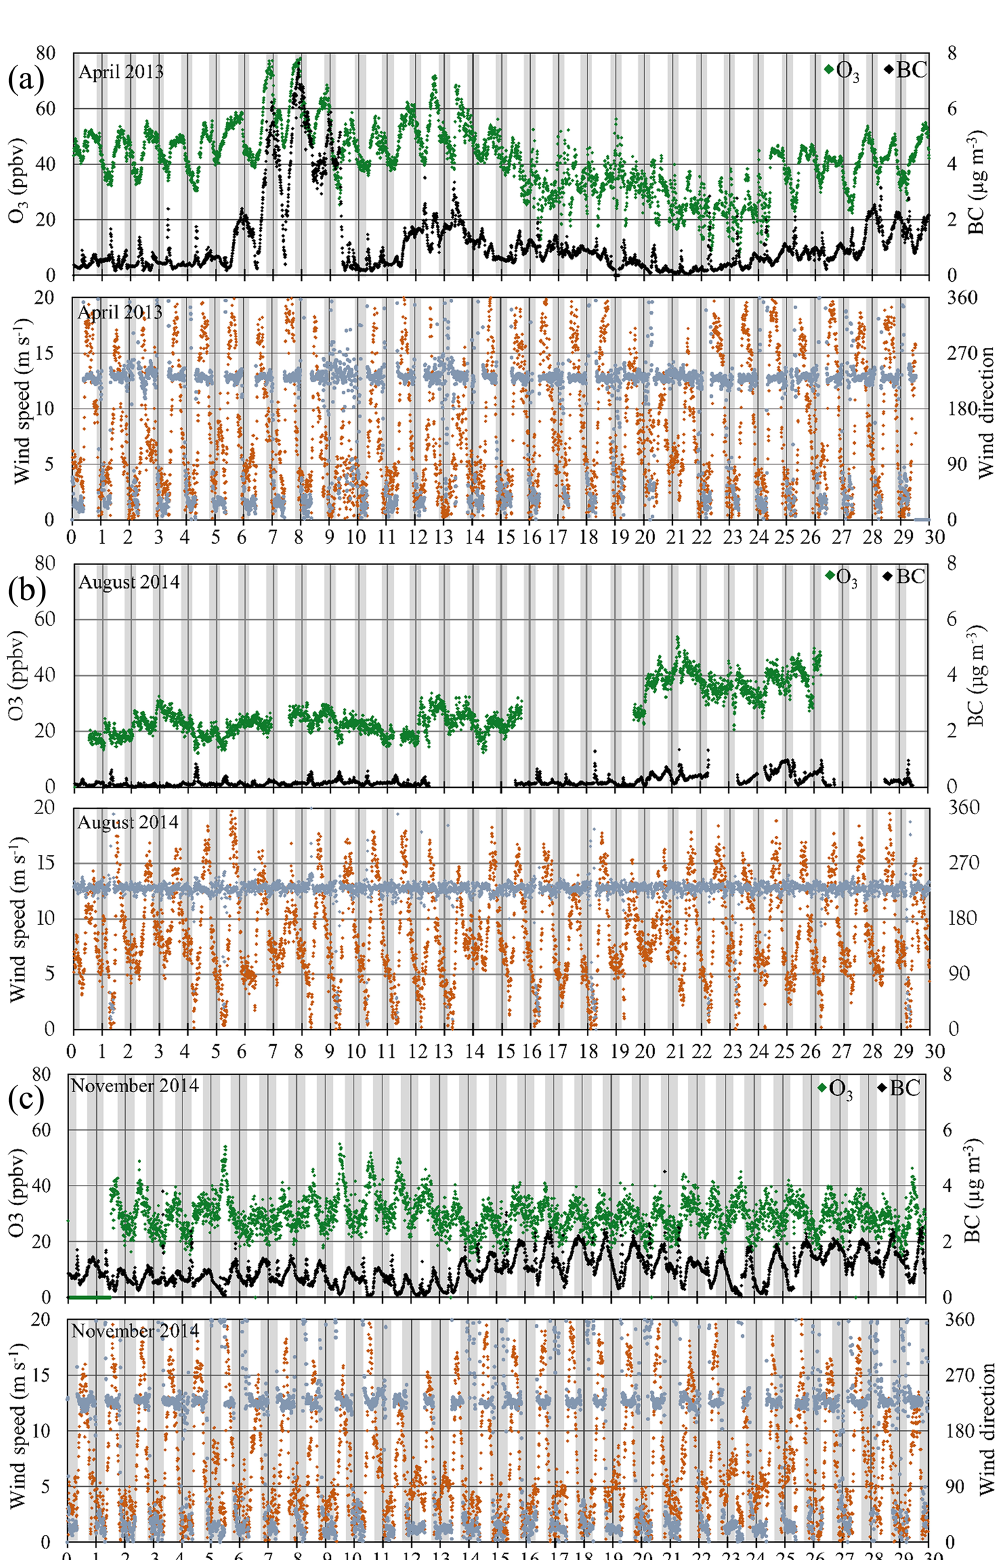
Figure 6. Variation in O 3 , BC, and associated wind speed and direction at JSM_STA during (a) April 2013 (pre-monsoon), (b) July 2015 (monsoon), and (c) November 2014 (post monsoon). The gray shaded area denotes